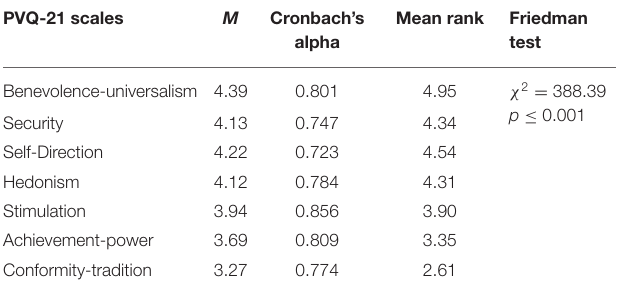
TABLE 2 | Comparative analysis of the value orientation dominance among Russians during the COVID-19 pandemic (PVQ-21). PVQ-21 scales M Cronbach’s